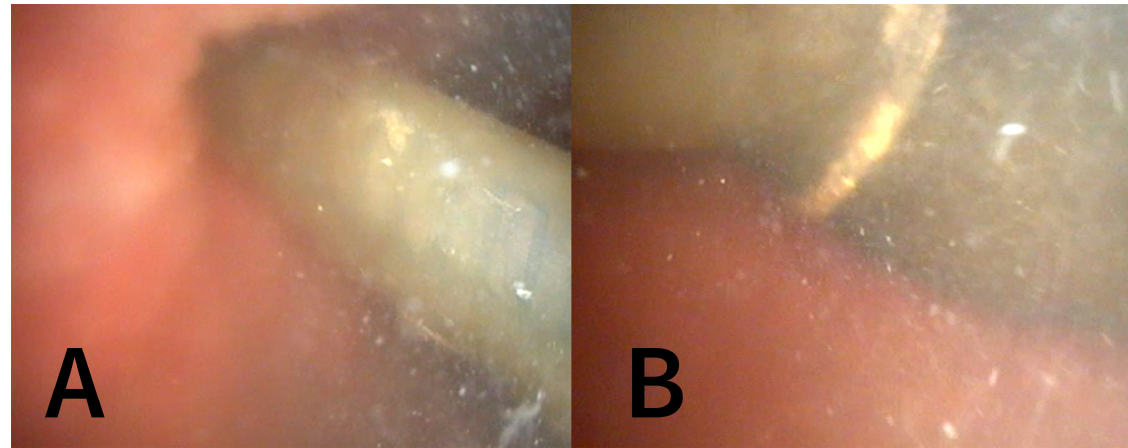
Fig. 1. Cystoscopy. (A) The tube erosion through the bladder wall. (B) The eroded reservoir completely inside the bladder.